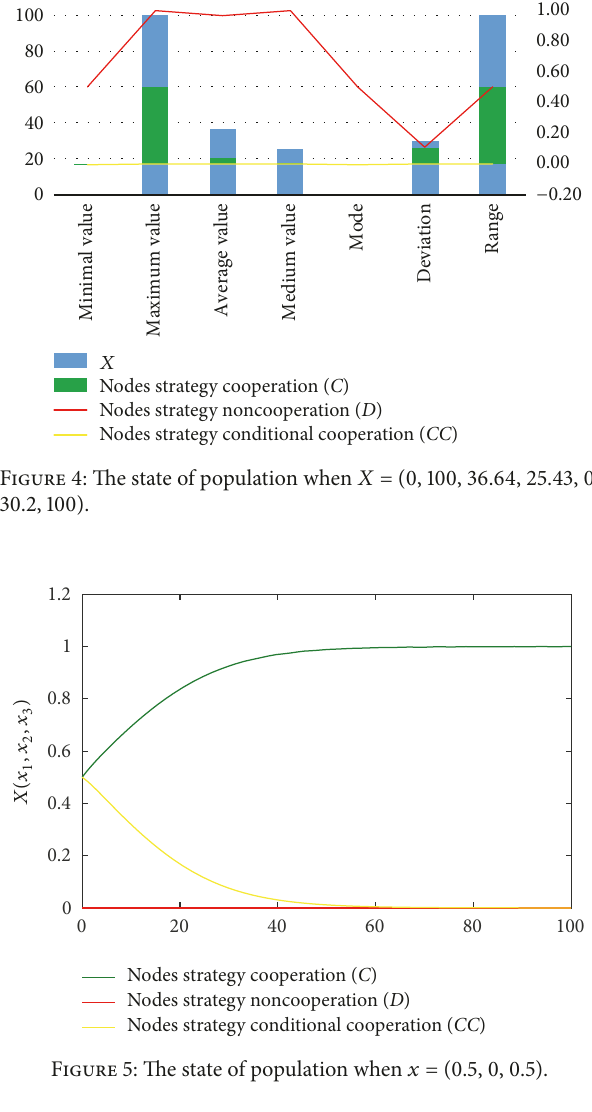
Table 4: The statistical analyses of strategies 𝐶 , 𝐷 , and 𝐶𝐶 .